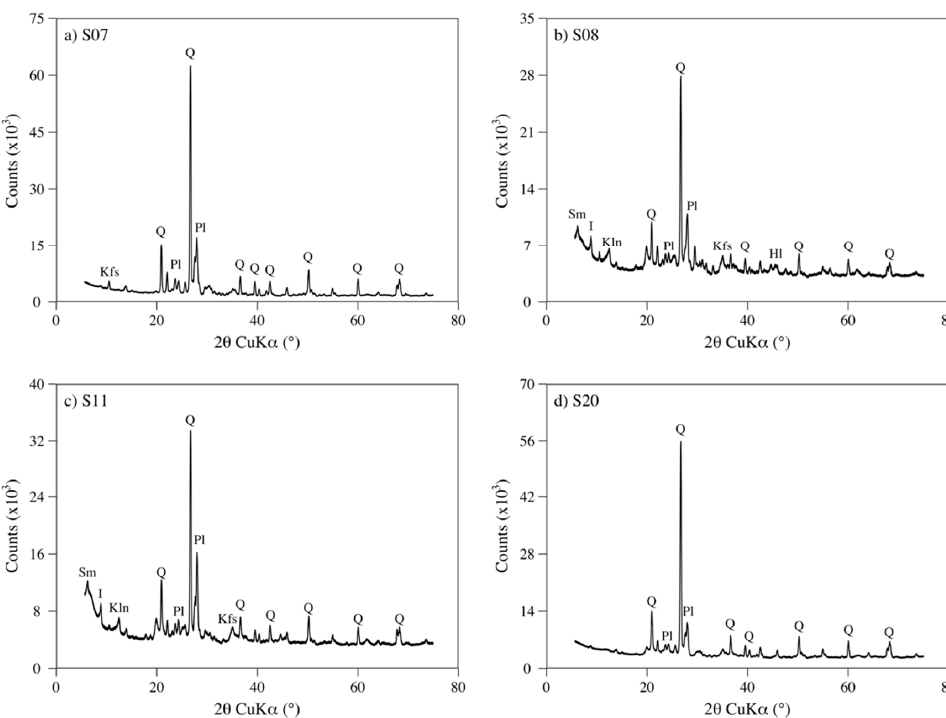
Figure 3. X-ray diffraction patterns of samples: ( a ) S07; ( b ) S08; ( c ) S11; and ( d ) S20. Note: Hl = halite, I = illite, Kfs = potassium feldspar, Kln = kaolinite, Pl = intermediate plagioclase, Q = quartz, and Sm = Smectite.